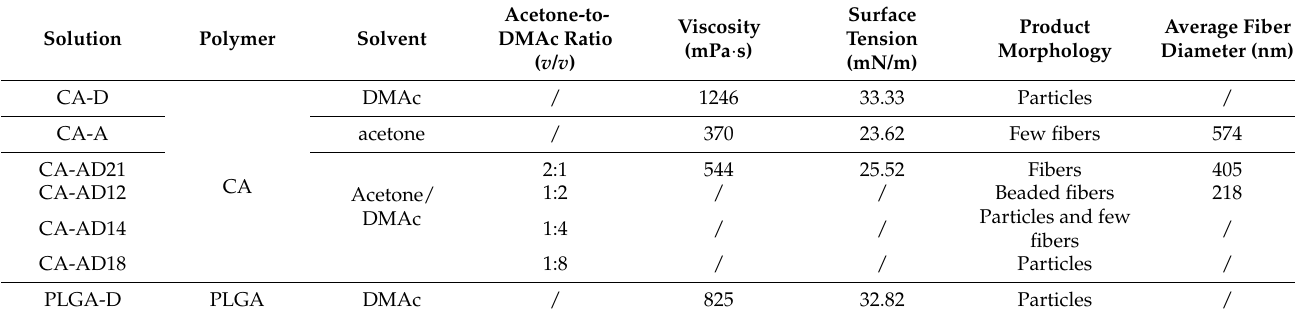
Table 1. Solution properties and electrospinnability of CA and PLGA